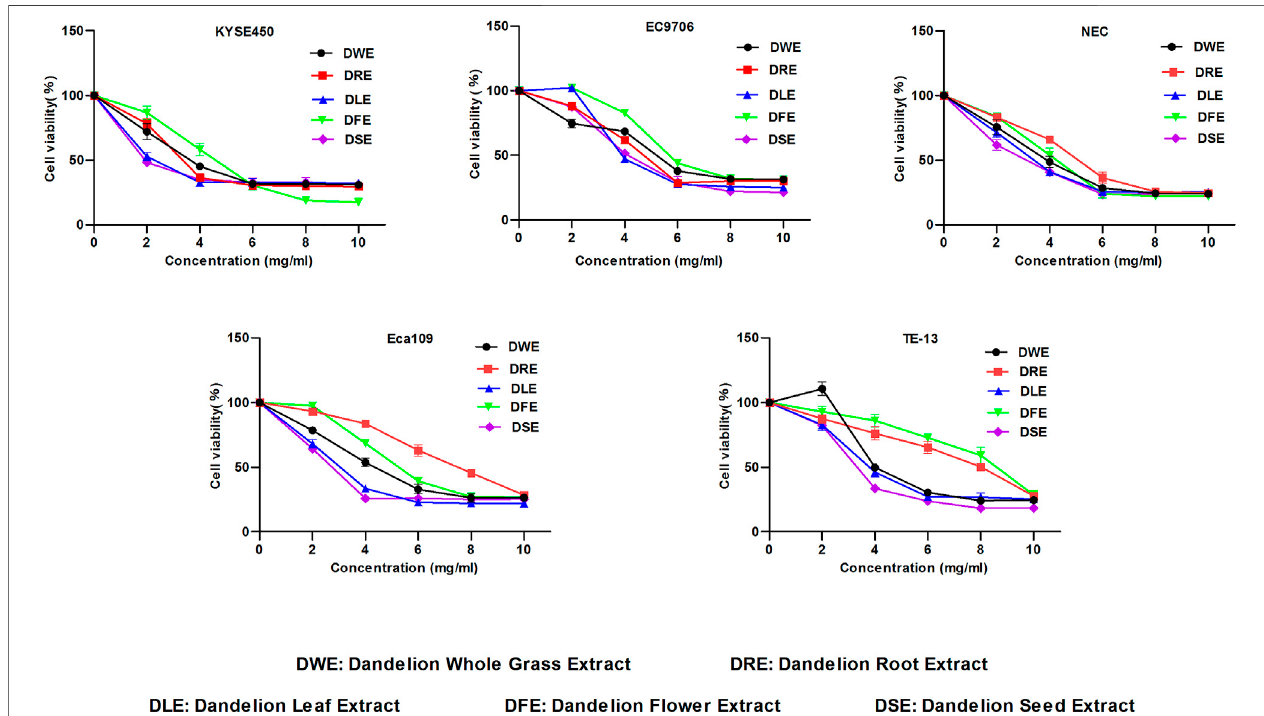
FIGURE 1 | Effect of DWE, DRE, DLE, DFE and DSE on cell viability of ESCC cells. MTS assay was used to detect the cell viability of KYSE450, EC9706, NEC, Eca109 and TE-13 cells. All data are expressed as mean ± standard deviation ( n = 3). DWE: Dandelion Whole Grass Extract; DRE: Dandelion Root Extract; DLE: Dandelion Leaf Extract; DFE: Dandelion Flower Extract; DSE:Dandelion Seed Extract.